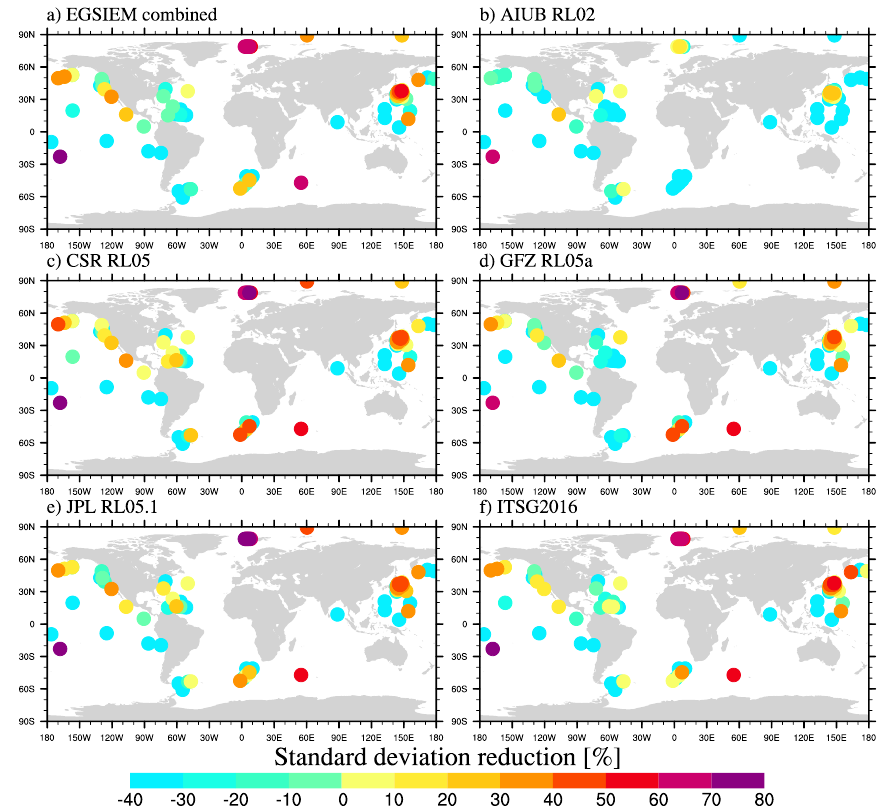
Figure 7. Standard deviation reductions over 103 ocean bottom pressure in-situ stations with GRACE-derived pressure.